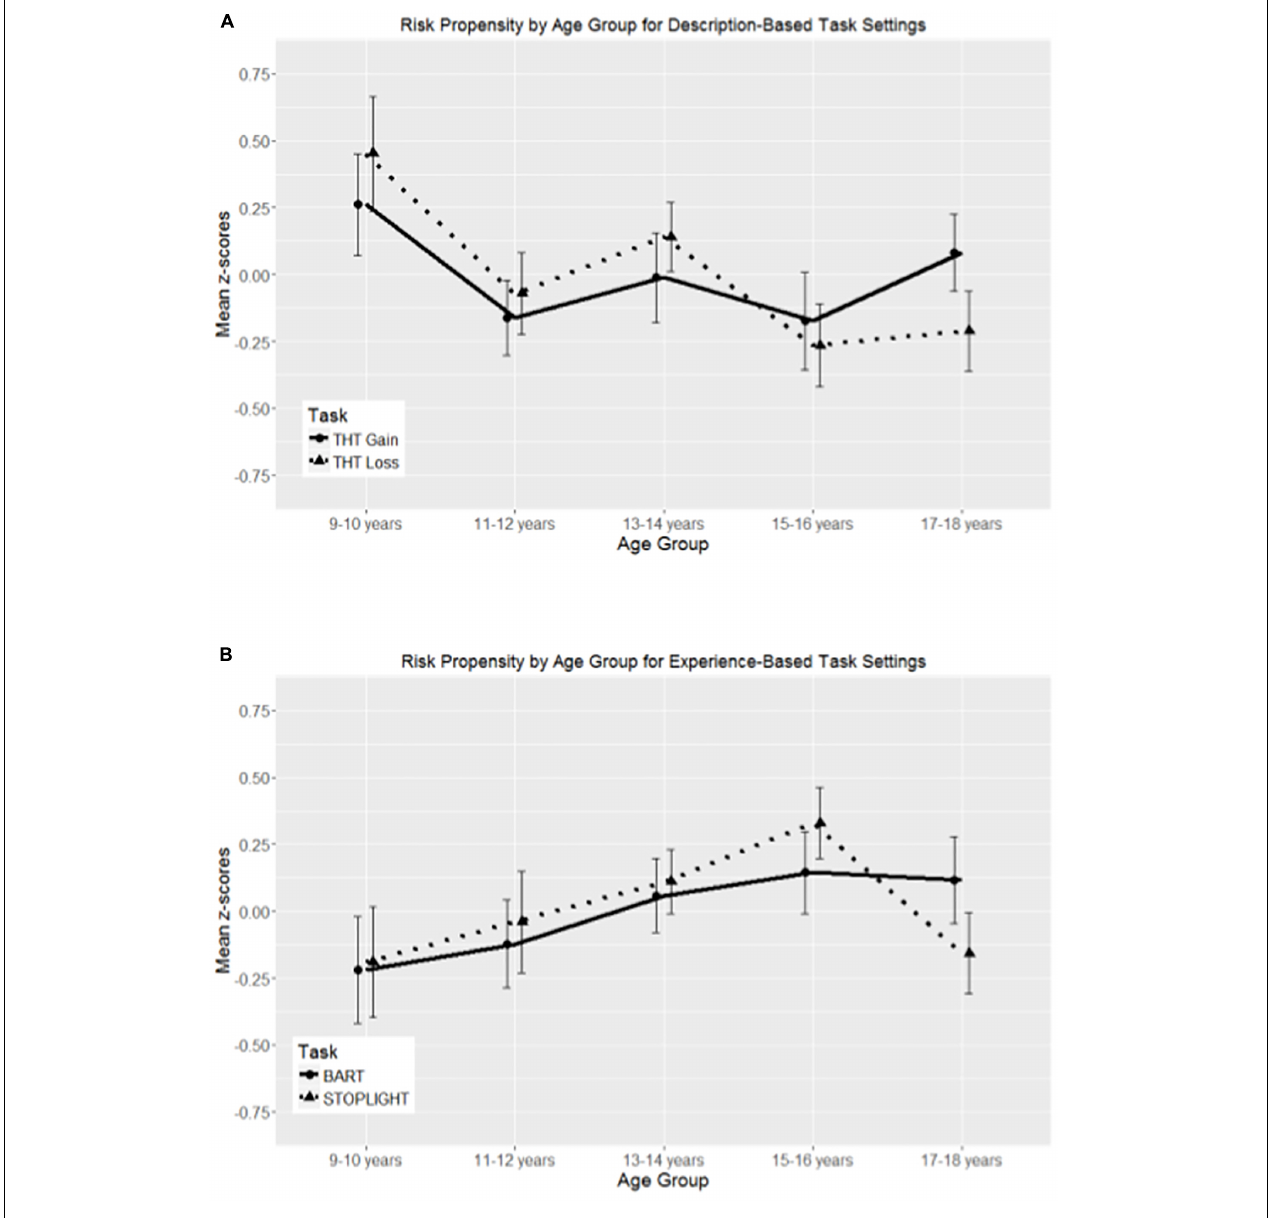
FIGURE 4 | Mean z -scores of the four experimental decision-making tasks as a function of age group, presented separately for experience- (A) and description-based (B) task settings. Error bars represent standard errors. Points are offset horizontally so that error bars are